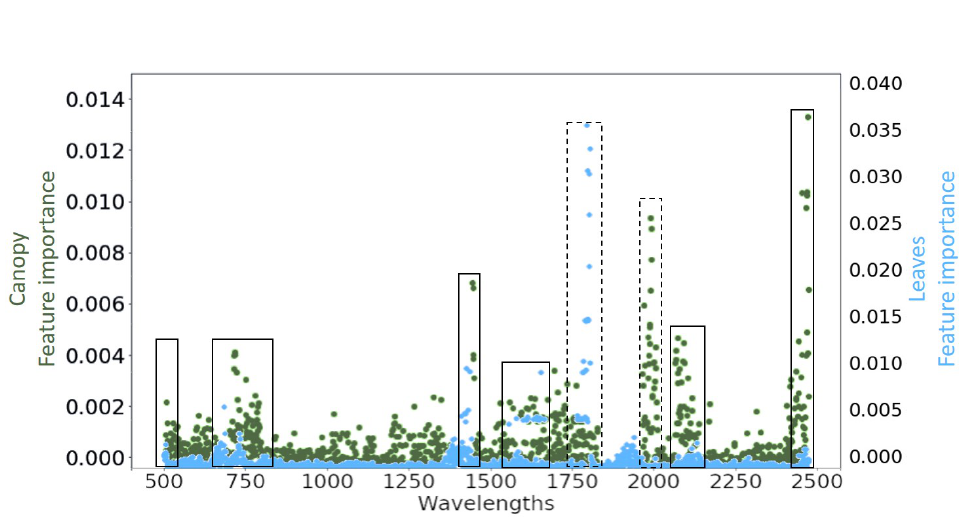
Figure 23. Feature importance with ExtraTrees Regressor methods for all plots with leaves and canopy reflectance. Same highlighted domains are surrounded by black lines, differences are surrounded by dotted